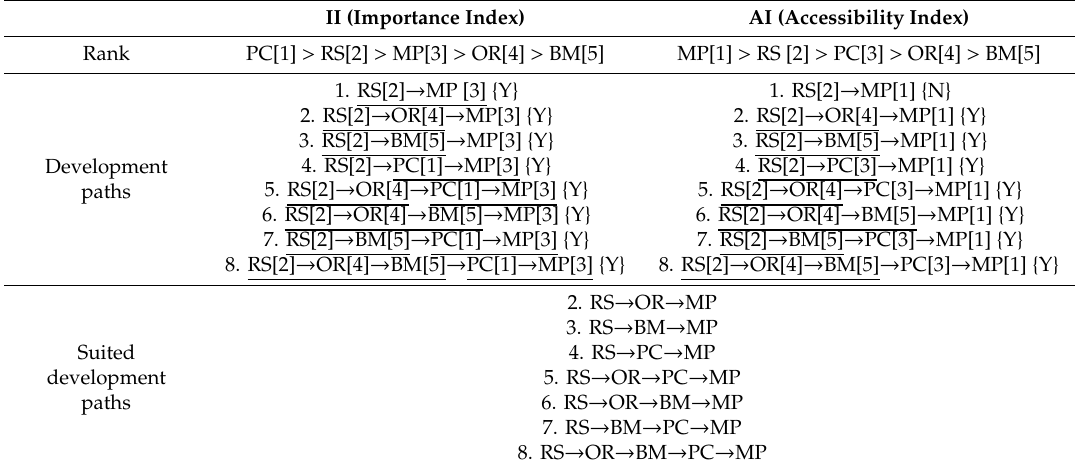
Table 12. The suited development paths for industrial entry.